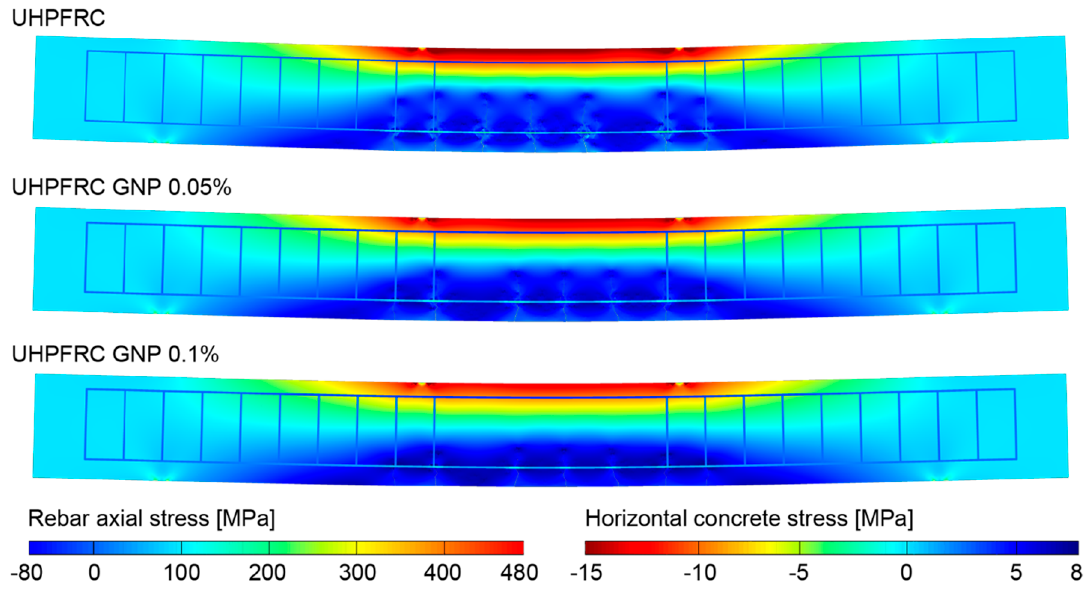
Figure 10. Deformed configurations (magnified by a multiplicative factor equal to 15) and stress maps for the three simulated steel bar-reinforced GNP-enhanced UHFRC beams at a load level of 45 kN. Table 5. Average crack width, crack spacing, and deflection of the simulated beams at a load level of 45 kN. Average Crack Width [mm] Crack Spacing [mm] Beam Deflection [mm] UHPFRC 0.027 100 1.20 UHPFRC GNP 0.05%